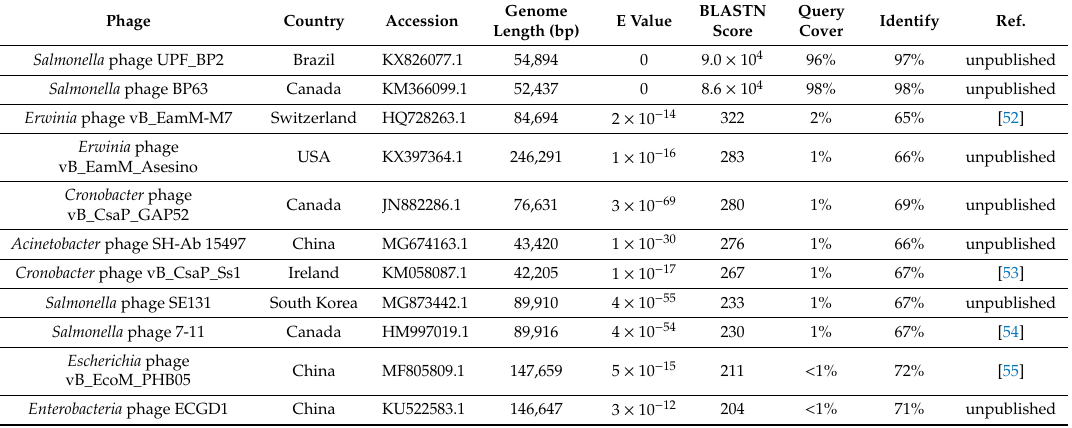
Table 2. Comparison of phages with BLASTN scores of more than 200 against the LPSEYT genome.